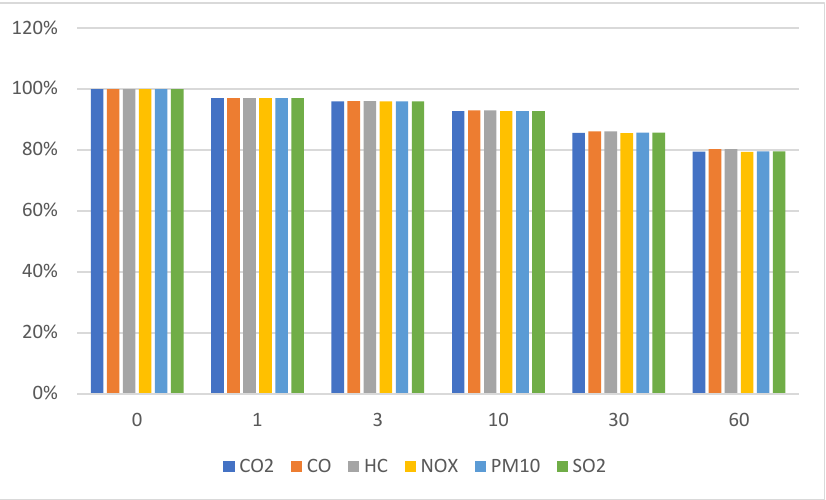
Figure 7. Average ratios of emissions of CO 2 , CO, HC, NO X , PM10, and SO 2 from the six ships in one year with thinning at different time intervals and without thinning.